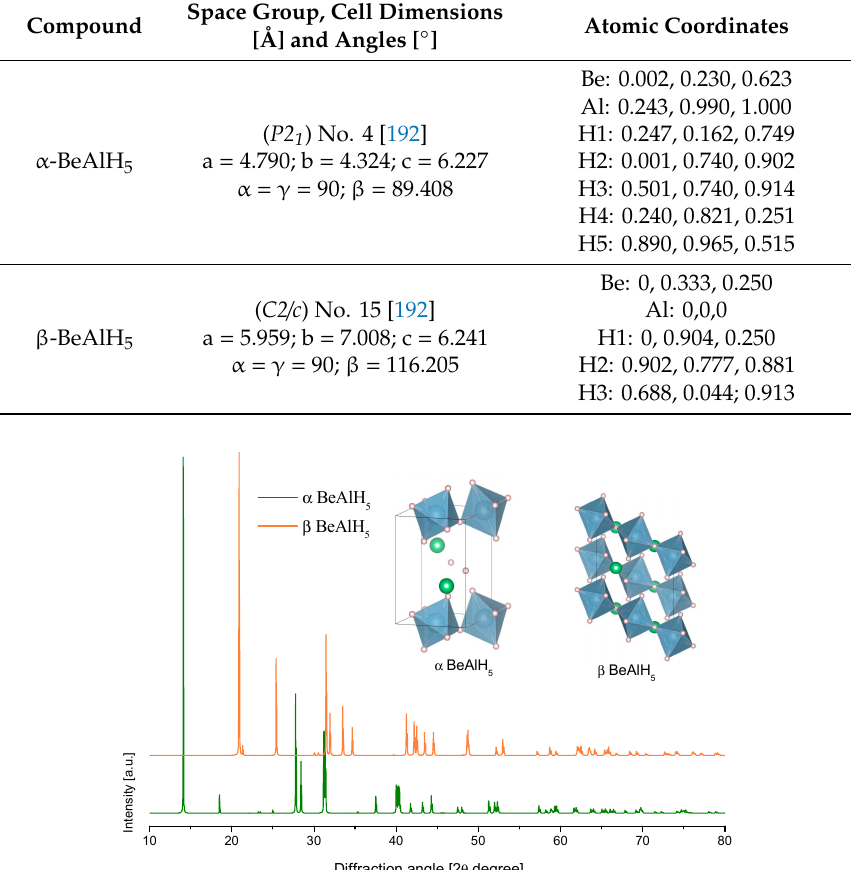
ff raction patterns ( λ = Cu k α 1